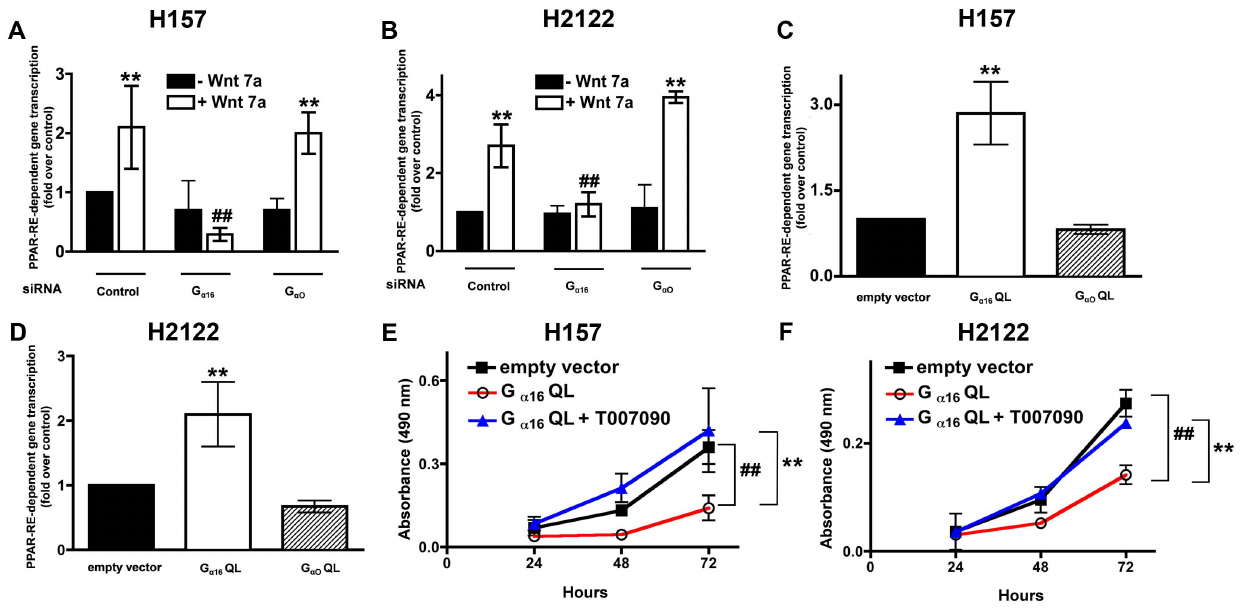
Figure 5. G a 16 regulates Wnt7a/Fzd9-mediated PPAR c activation. NSCLC cell lines, H157 (A) or H2122 (B) cells were transfected either with control siRNA or G a 16 -specific siRNAs together with PPAR-RE-luciferase reporter and either without or with Wnt7a expression vector. After 48 h, the lysates were assayed for luciferase activities as described in the Methods. Data represents mean 6 SEM of three separate experiments. **, p , 0.01; versus empty vector control. ## , p , 0.01; versus Wnt7a. NSCLC cell lines, H157 (C) or H2122 (D) cells were transfected either with empty vector or constitutively active G a 16 Q212L or G a o Q205L expression vectors together with PPAR-RE-luciferase reporter. After 48 h, the lysates were assayed for luciferase activities as described in the Methods. Data represents mean 6 SEM of three separate experiments. **, p , 0.01; versus empty vector control. NSCLC cell lines, H157 (E) or H2122 (F) were transfected with either empty vector or constitutively active G a 16 Q212L. After 24 h, the cells were treated either with or without PPAR c inhibitor (T0070907, 10 m M) as described in the Methods. Cell proliferation rates were later determined using an MTS assay as described in the Methods. Data represents mean 6 SEM from three independent highly reproducible experiments. ## , p , 0.01; versus empty vector control. **, p , 0.01; versus G a 16 Q212L +